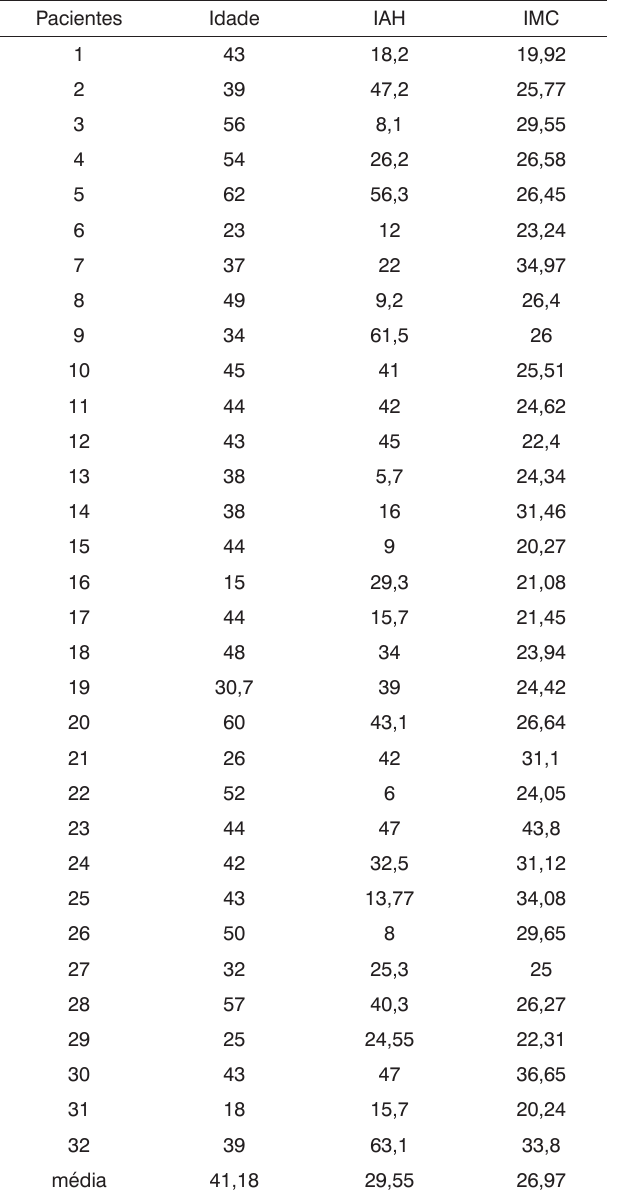
Tabela 1. Dados dos 32 pacientes estudados referentes à faixa etária (anos), IAH (eventos/hora de sono) e IMC (Kg/cm 2